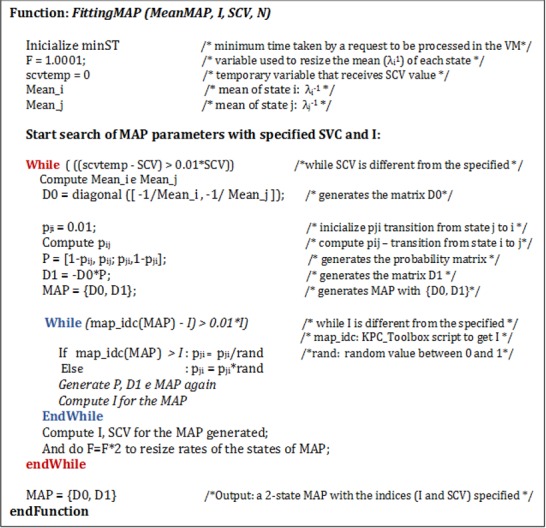
Pseudo Code–defining the parameters of the MAP.Script for fitting the parameters of a MAP to model bursts in the arrival process, considering the main measures as average, I and SCV of the MAP.